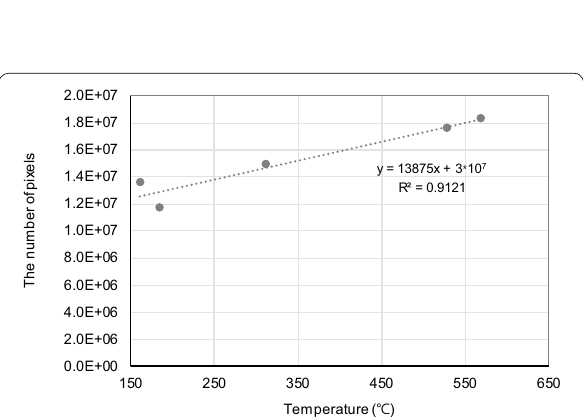
y = 13875x + 3 (cid:13) 10 7 R² = 0.9121